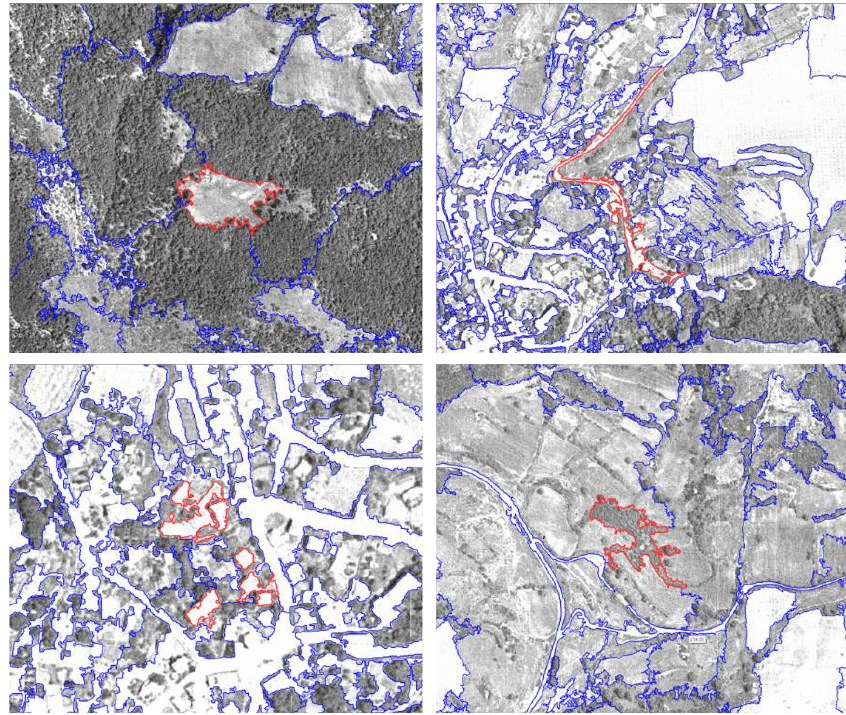
Figure 15. Segmented 1965 Ruen aerial photograph. Segments highlighted by red borders show the objects resulting from small-scale